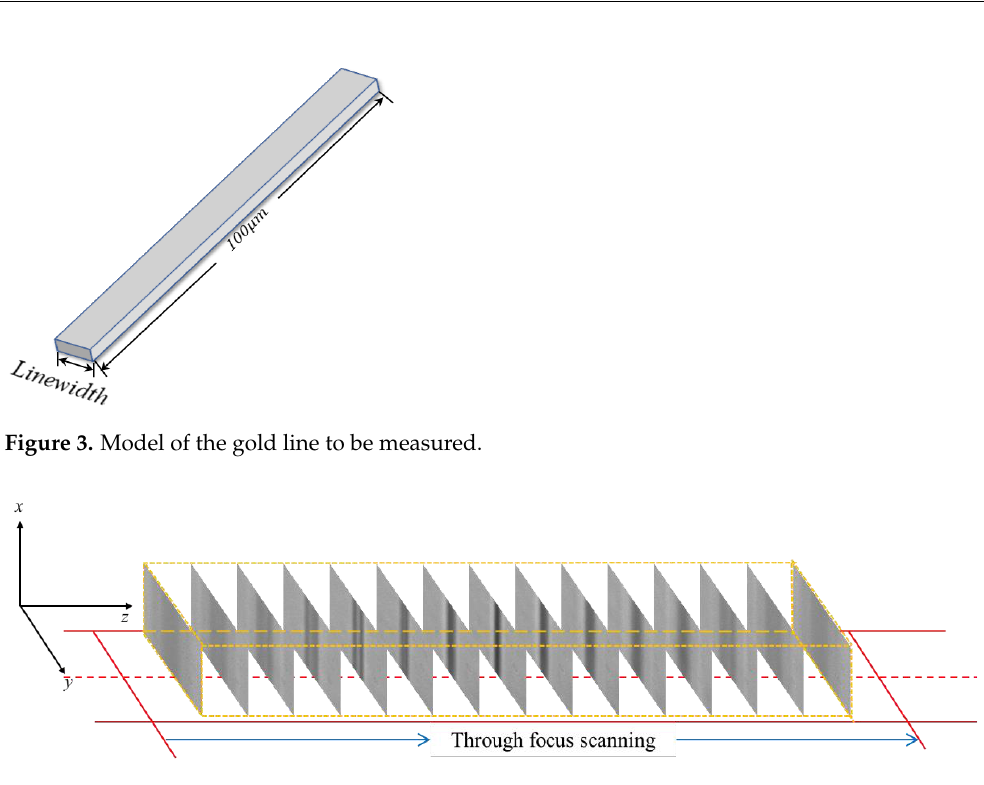
Figure 4. The TSOM cube consists of a series of images collected by through-focus scanning, as shown by the yellow cube. The optical axis is along the z direction of the coordinate system and the imaging plane is parallel to the xoy plane while scanning.